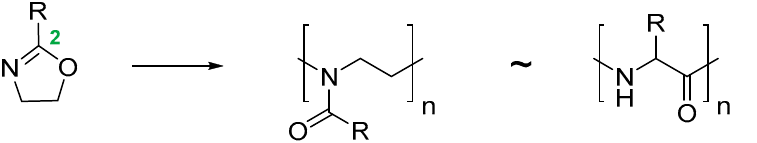
Figure 1. Polymerization of 2-oxazolines and their structural similarity with poly(amino acid)s.